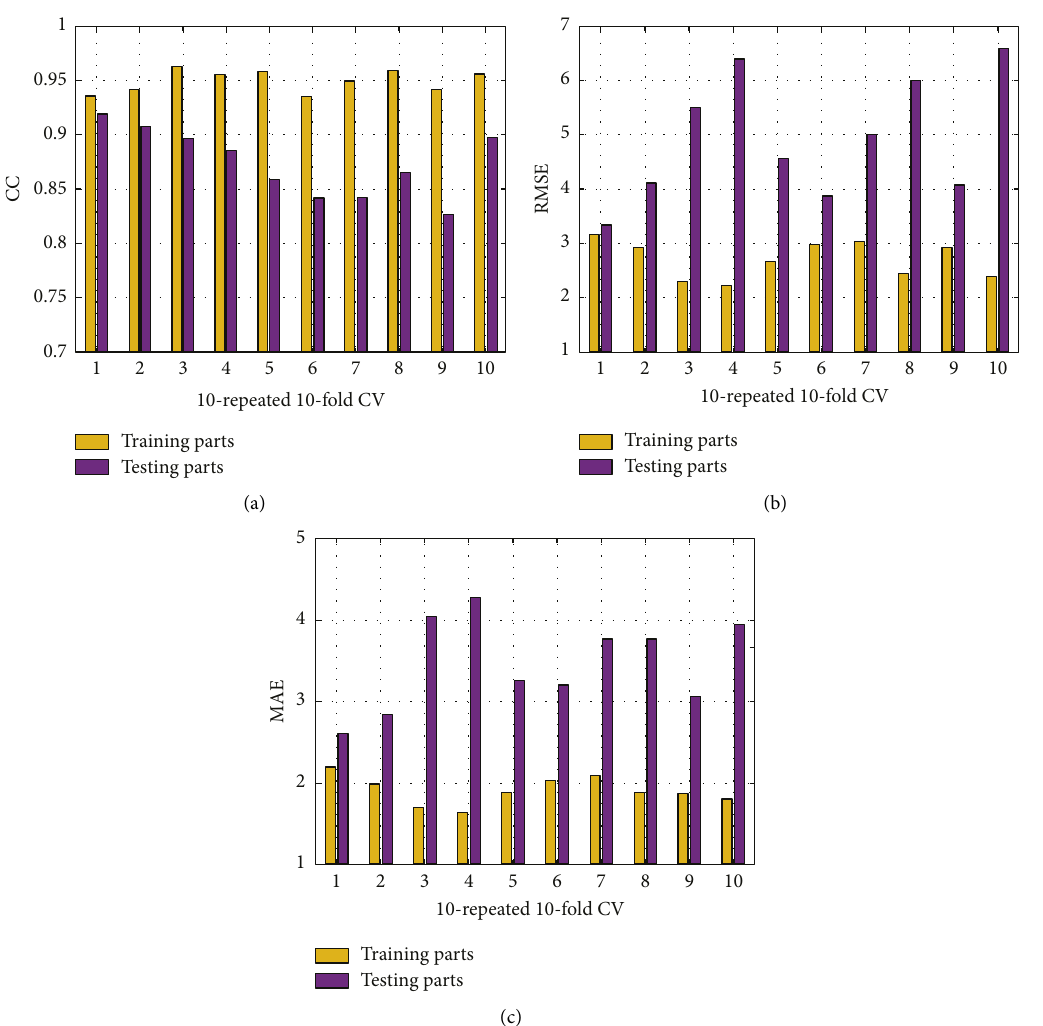
Figure 6: Results of training and testing phases of EDT model after 10 repeated 10-fold cross-validation based on different performance criteria: (a) CC; (b) RMSE; and (c)